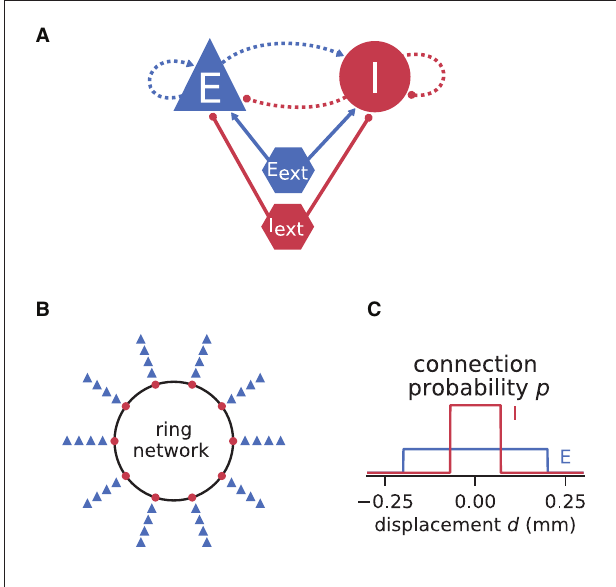
FIGURE 7 | Illustrations of spiking network model by Senk et al. (2020). (A) Excitatory and inhibitory neuronal populations randomly connected with fixed in-degree and multapses allowed (autapses prohibited). External excitatory and inhibitory Poisson drive to all neurons. Same notation as in Figure 2A . (B) One inhibitory and four excitatory neurons per grid position on a one-dimensional domain with periodic boundary conditions (ring network). (C) Normalized, boxcar-shaped connection probability with wider excitation than inhibition; the grid spacing is here 10 − 3 mm. For model details and parameters, see Tables II–IV of Senk et al. (2020); the specific values given in the caption of their Figure 6 are used throughout here.